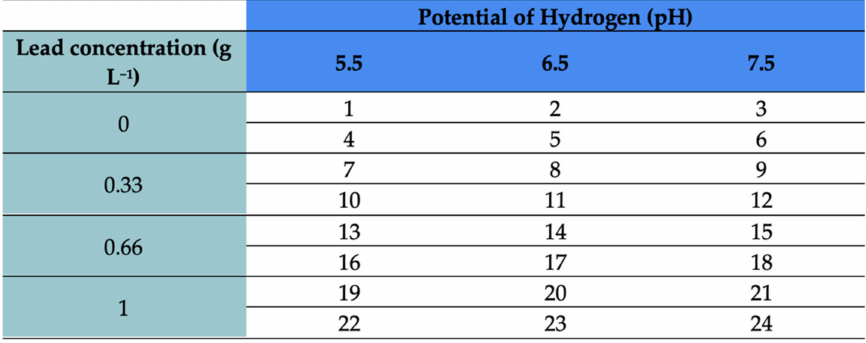
Figure 5. Factors and levels used for the experimental design. Data collected by the